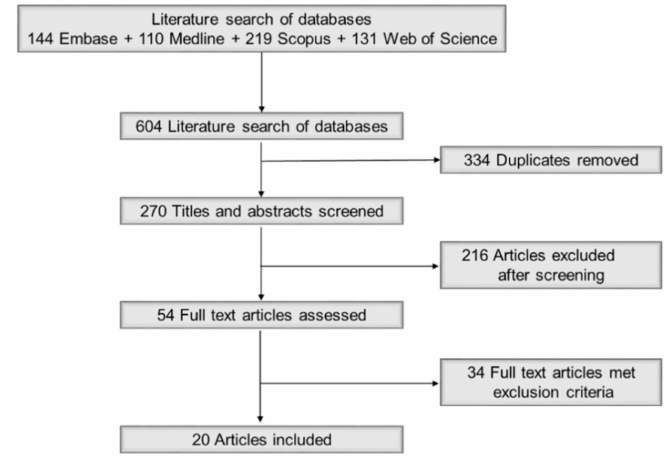
Figure 1. PRISMA flow chart of the literature screening and selection